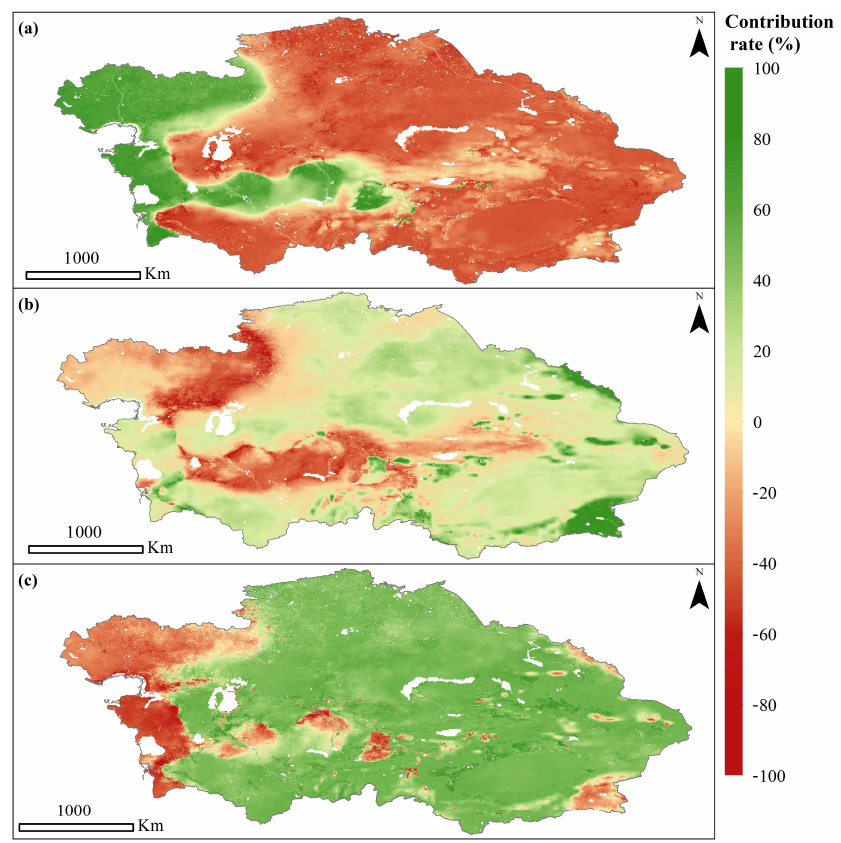
Figure 3. Spatial variation in the contribution rates (%) of annual PET ( a ), P ( b ), and VH ( c ) to annual ET from 2000 to 2020. ET from 2000 to 2020.